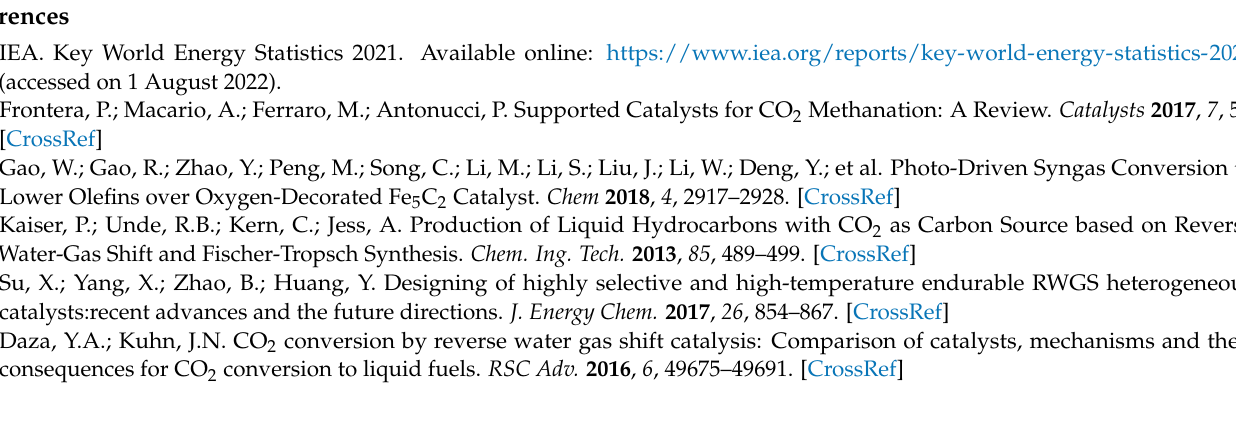
Figure S4: (a) TEM image and (b) diffraction pattern of S4 sample; (c) TEM image and (d) diffraction pattern of M4 sample; (e) HR-TEM with identification of anatase and rutile phases. (101) plane of anatase and (110) plane of rutile have been marked for all images. Figure S5: Energy dispersive X-ray analysis of (a) S2 and (b) M2 catalysts. Table S1: Elemental analysis of S4 and M4 samples using SEM-EDX, four different locations are probed, confidence intervals of 98% are reported. Figure S6: SEM-EDX spectrum of (a) M4; (b) S4 catalysts, O, Ti and Au peaks have been identified. Figure S7: (a) Diffuse reflectance UV-vis spectra for bare P25 TiO 2 , S1–4 and M1–4 catalysts; (b) First derivative of the diffuse reflectance UV-vis spectra of S2 and M2 catalysts. Intersection with the reference line around 550 nm highlights the position of the plasmonic Au absorption band. Table S2: Crystallite size determined for anatase and rutile in S4 and M4 samples, using Scherrer equation. Figure S8: AM1.5 irradiance of the solar simulator. Figure S9: (a) CH 4 production of M1–4 and S1–4 catalysts in dark at 200 ◦ C. (b) Initial reaction of the M1–4 and S1–4 catalysts in dark at 200 ◦